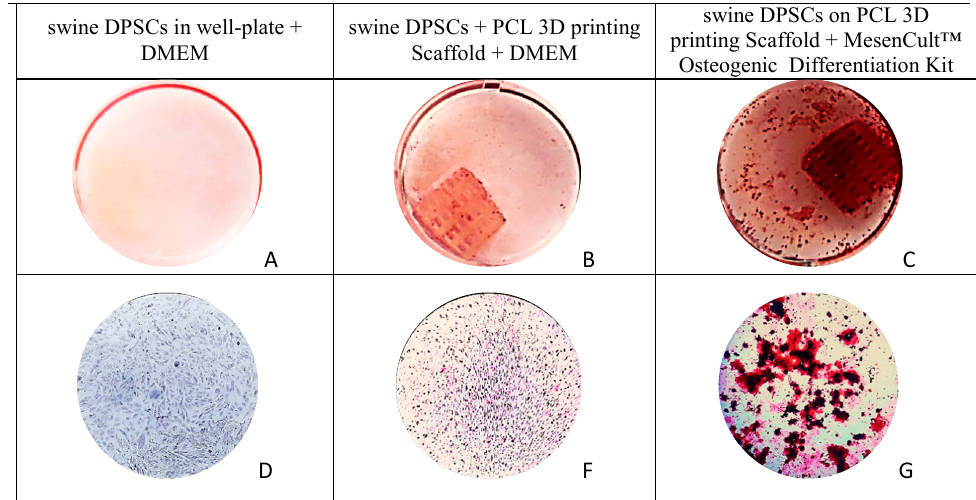
Figure 7. Representative images (top) of the mineral deposition in swine DPSCs on day 28 by Alizarin red S staining ( A – C ), and the respective microscopy images ( D – G ) at the bottom 10×.